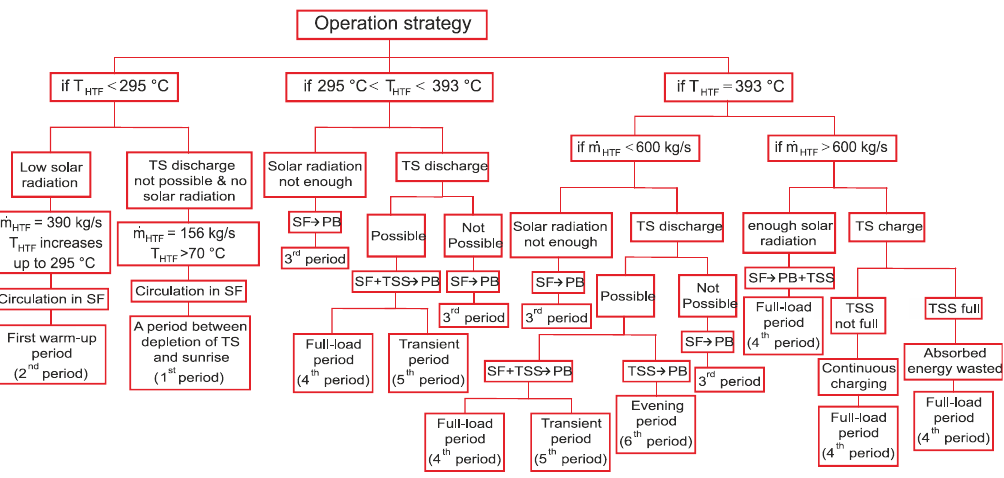
Figure 1. Schematic diagram of the operation strategy during a single day for a PTSPP model.